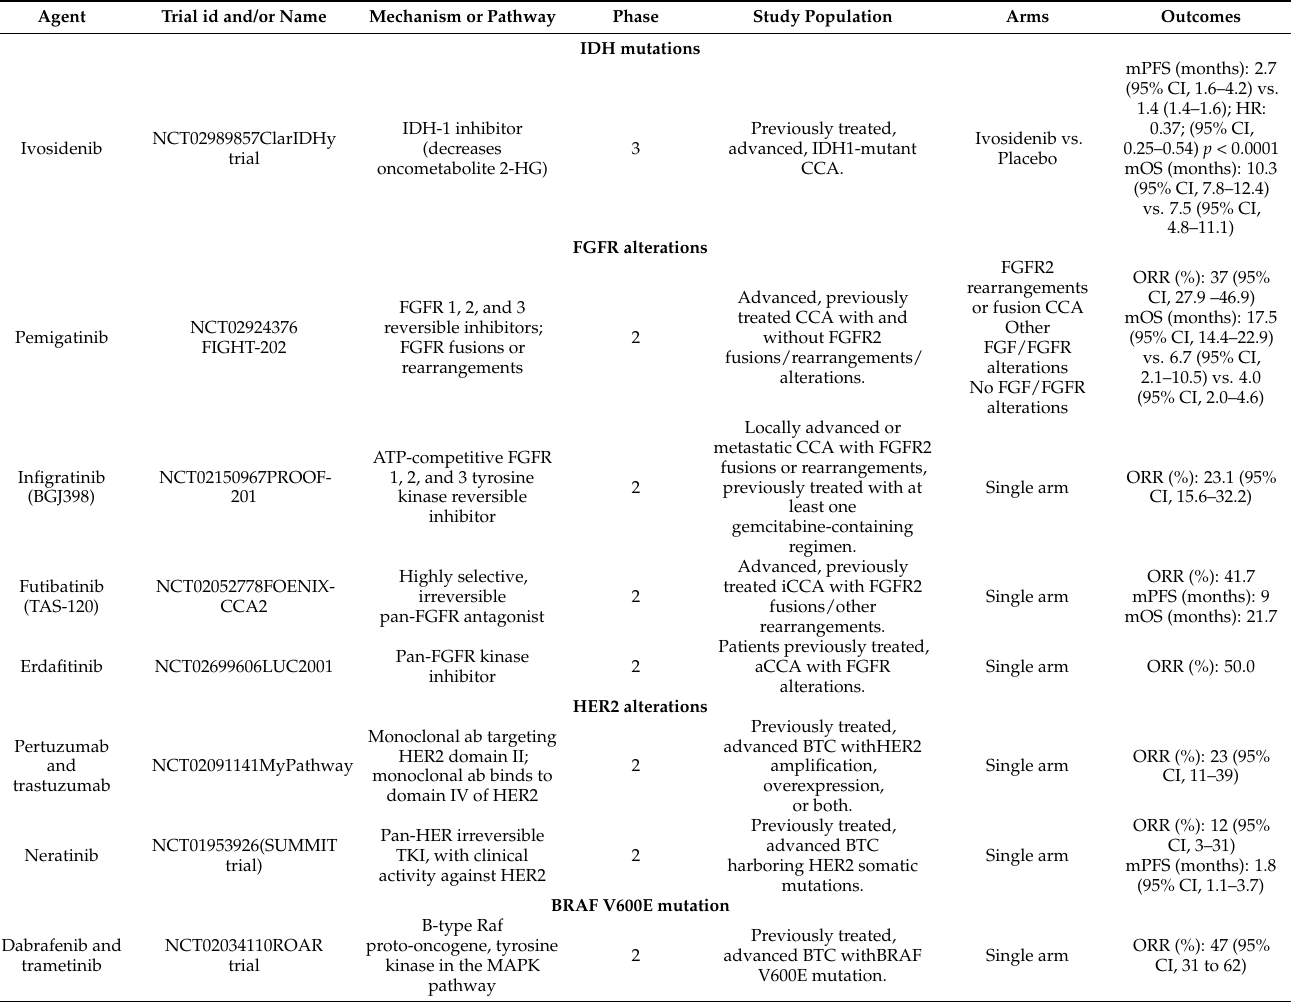
Table 2. Main trials of targeted therapy in